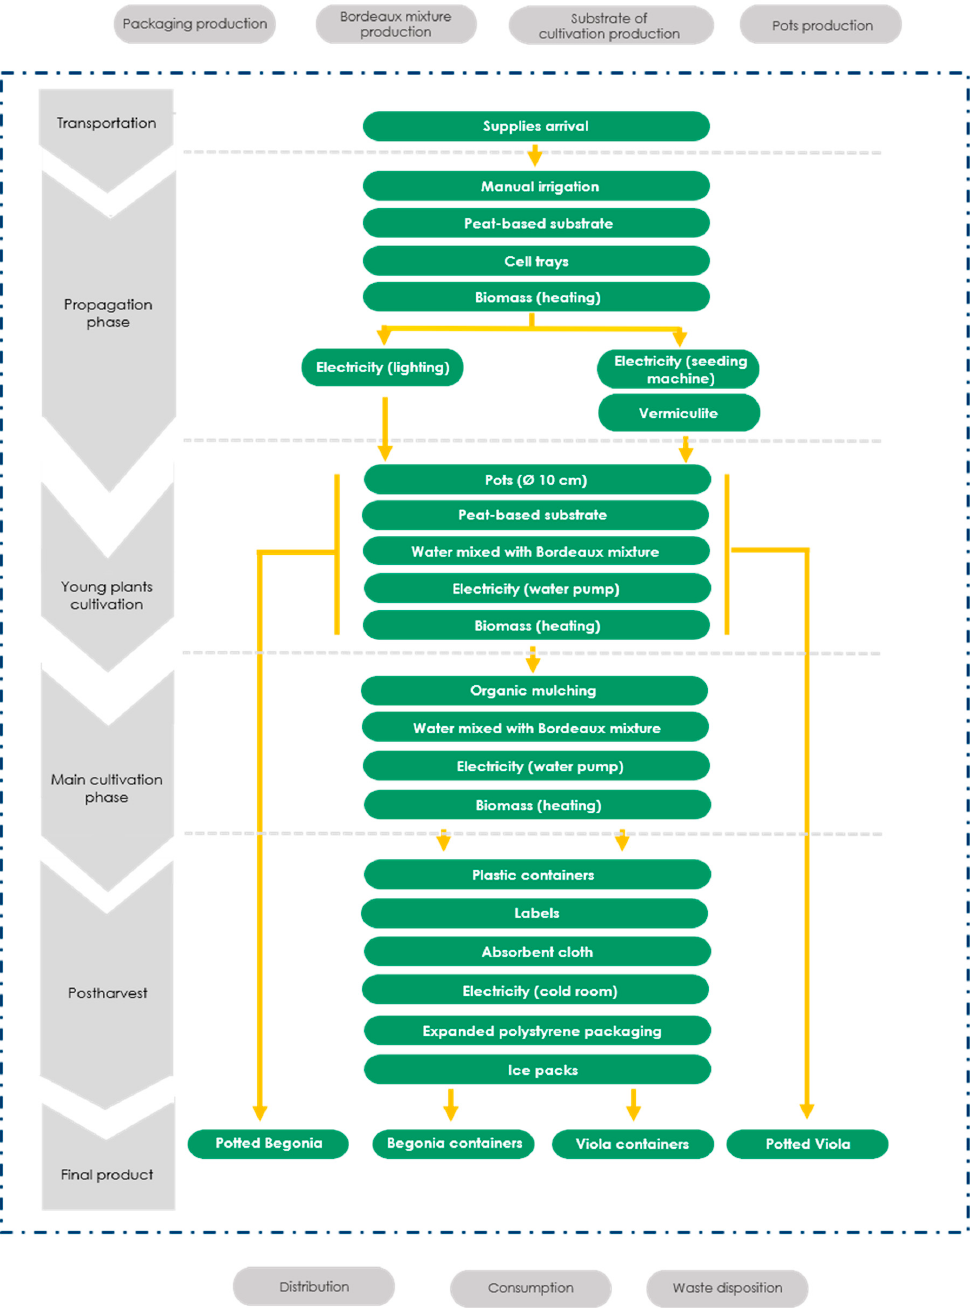
Figure 2. Schematic illustration of the boundary (blue square) and inputs (green labels) considered for the production cycle of packaged flowers and flowering potted plants of B. semperflorens and V. cornuta edible flowers in the nursery. Grey labels outside the boundary were not considered in the analysis (cradle to gate approach).